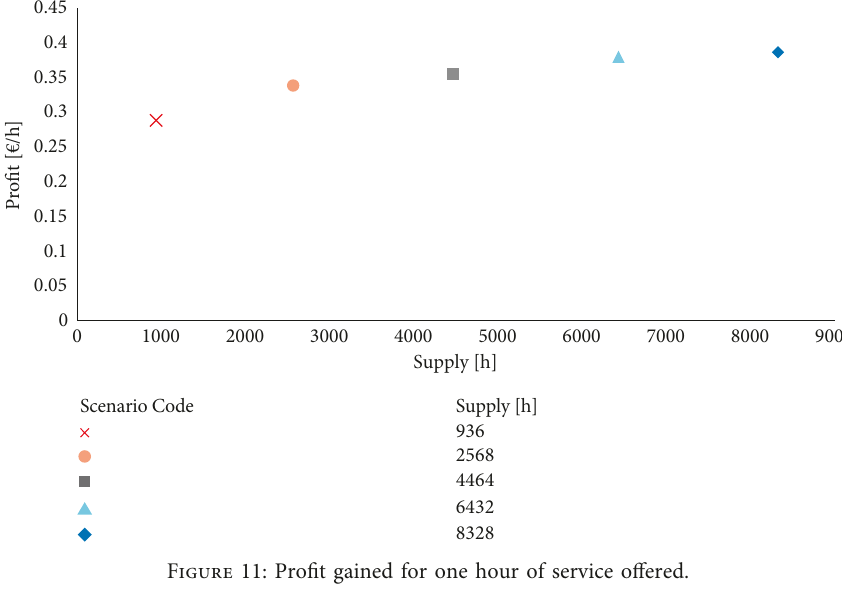
Figure 11: Profit gained for one hour of service offered.